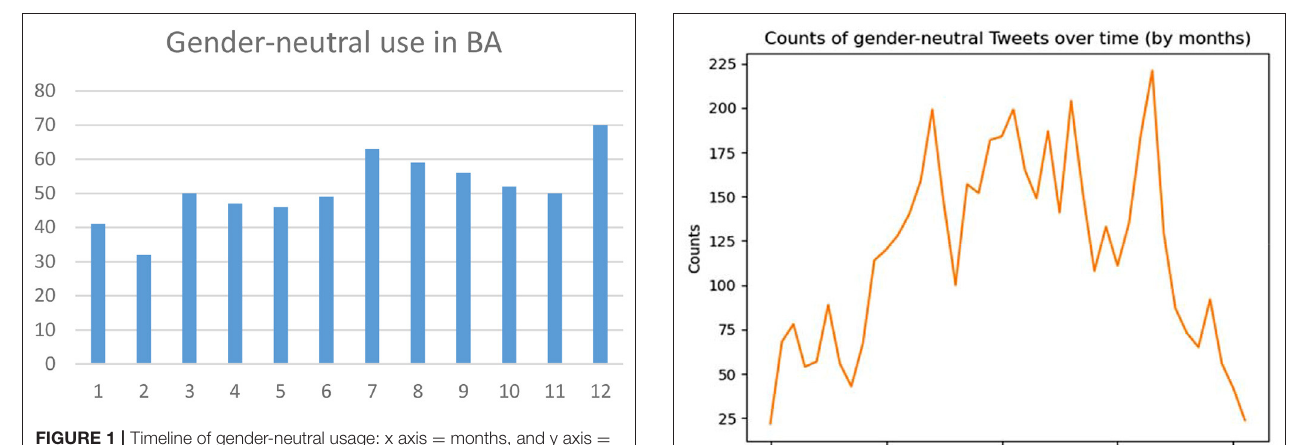
FIGURE 1 | Timeline of gender-neutral usage: x axis = months, and y axis = frequency of tweets.